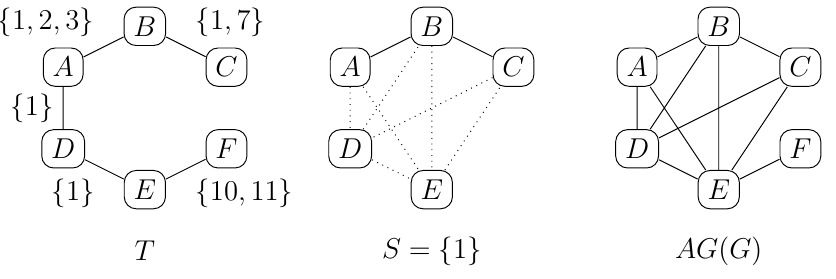
Figure 3. An execution of the algorithm Forest Figure 3: An execution of Algorithm Forest Join.